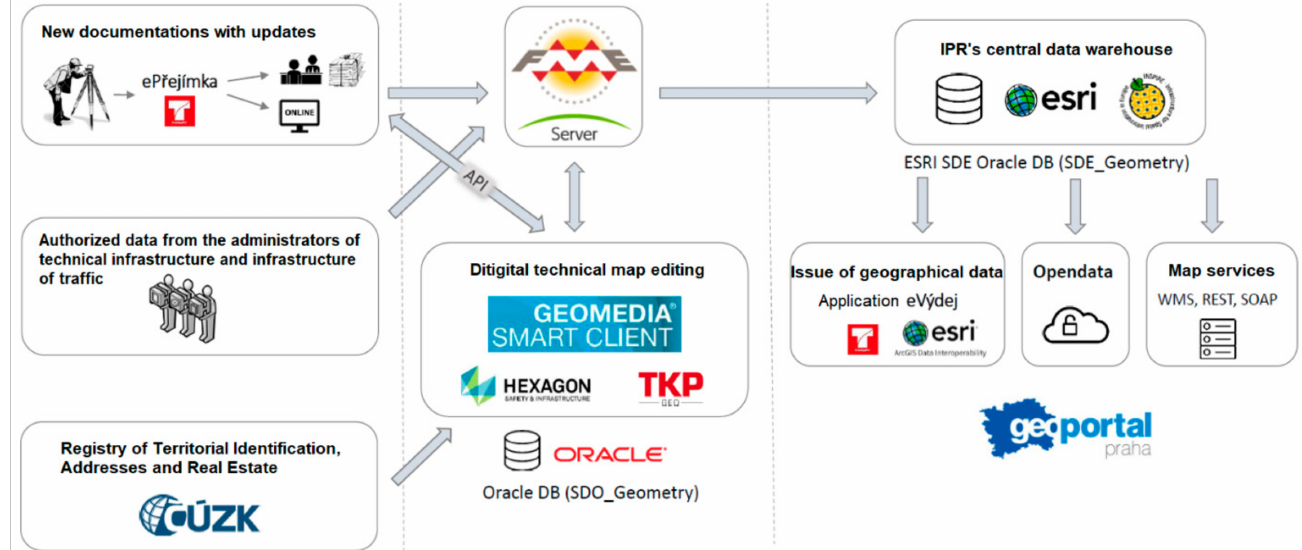
Figure 2. Technological solution of digital technical map of Prague [26].